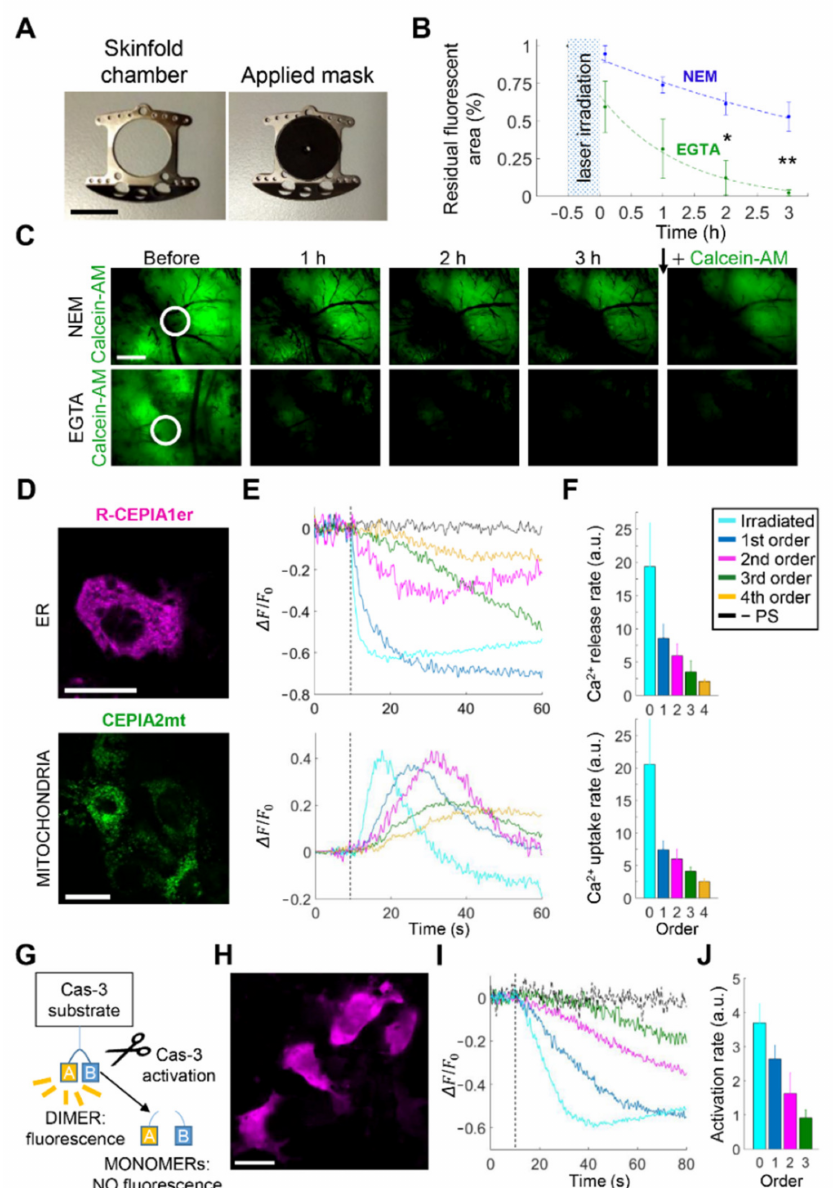
Figure 4. In vivo intratumor injection of ethylene glycol-bis( β -aminoethyl ether)-N,N,N (cid:48) ,N (cid:48) -tetraacetic acid (EGTA) prior to spatially confined photodynamic therapy (scPDT) boosts bystander cell killing via calcium (Ca 2+ )-dependent apoptotic pathways. ( A – C ) B16-F10 melanomas grown in the dorsal skinfold chamber (DSC) were loaded with the photosensitizer (PS) and partially irradiated (scPDT, 30 min duration, irradiance ~378 mW/cm 2 ) after microinjection of normal extracellular medium (NEM, control conditions) or Ca 2+ -free extracellular medium supplemented with 5 mM of EGTA (EGTA conditions). Tumor cell demise was assayed by time-lapse microscopy using calcein-AM (co-loaded with PS); ( A ) DSC titanium frame (left) with applied opaque mask (right) used to restrict melanoma irradiation in scPDT experiments (central hole diameter = 1.3 mm); scale bar: 1 cm; ( B ) Post-irradiation variation of melanoma surface area with persistent calcein-AM fluorescence in control (NEM; n = 4, blue) and EGTA ( n = 3, green) conditions. Interpolating curves (dashed lines) were computed by data fitting with the function f( t ) =1 − a + ae − b ( t + c ) (for parameter values, see Table S3). *, p < 0.05; **, p < 0.01, two-tailed t -test; ( C ) Representative results of time-lapse fluorescence imaging with calcein-AM. Images were acquired before and after scPDT (within white circles) at shown time points; the black down arrow marks the time point of calcein-AM reloading in the tumors (3 h 30 min); scale bars: 1 mm; ( D – J ) Experiments were performed in B16-F10 syngeneic melanomas exposed to NEM, expressing one of the following genetically encoded fluorescent indicators: R-CEPIA1er, a Ca 2+ indicator targeted to the endoplasmic reticulum (ER, D – F , top); CEPIA2mt, a Ca 2+ indicator targeted to